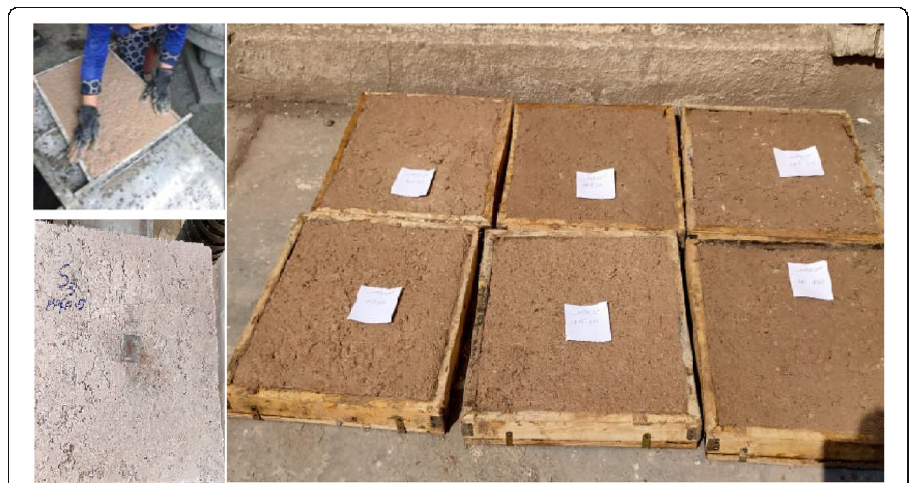
Fig. 1 Mixing, casting, and preparing to test of PPFGPCs